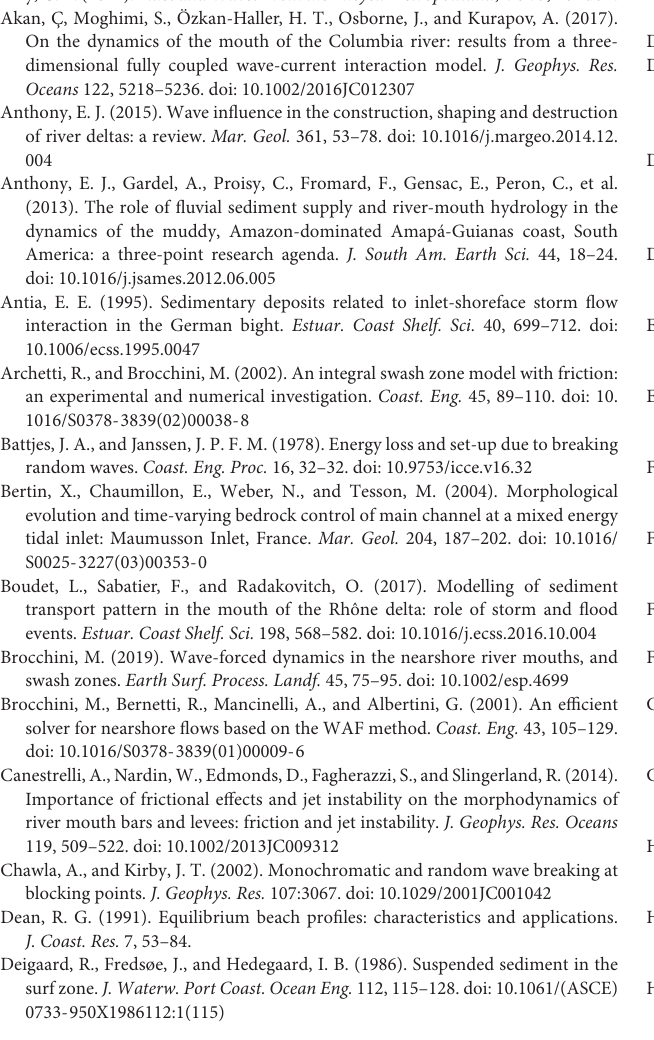
DHI (2017a). MIKE 21 & MIKE 3 Flow Model FM - Hydrodynamic and Transport Module, Scientific Documentation , Hørsholm, DHI,